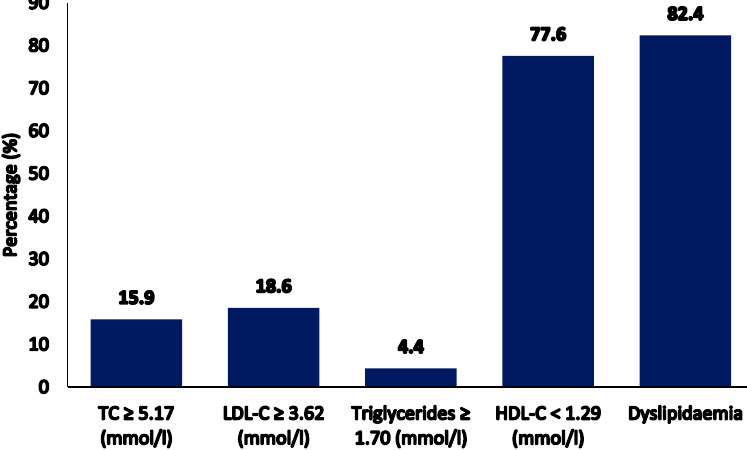
Figure 1. Prevalence of abnormal lipid parameters and dyslipidemia.